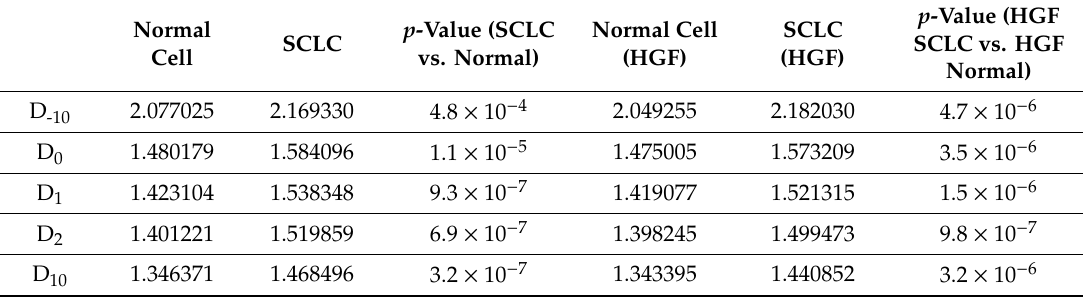
Table 1. D -10 , D 0 , D 1 , D 2 , and D 10 of the mitochondrial network of BEAS-2B and SCLC cells in control and HGF-stimulated